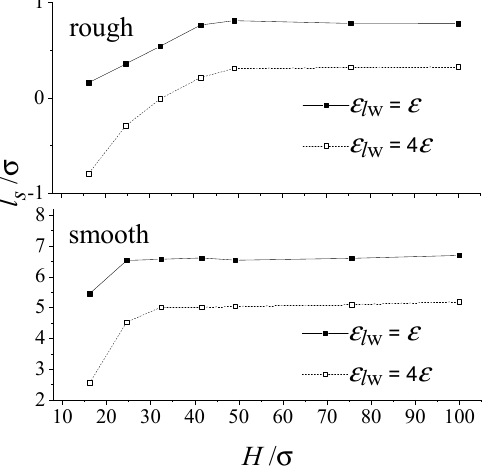
Figure 5. Effect of the confined scale on the interface slip ( ρ w = 2 ρ , rough: S = 19.6 σ , δ = 1.57 σ ).